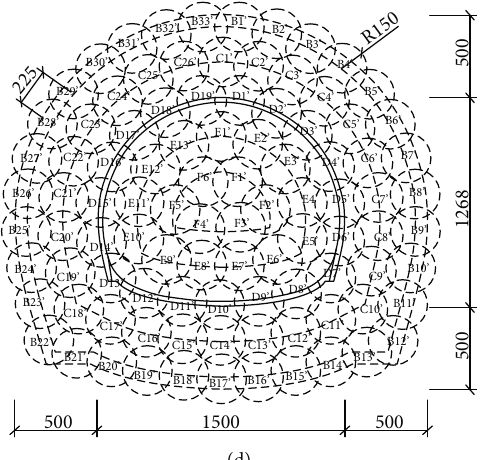
Figure 11: Layout of grouting boreholes: (a) longitudinal pro fi le, (b) cross-section, (c) supplementary cross-section, and (d) fi nal cross- section.